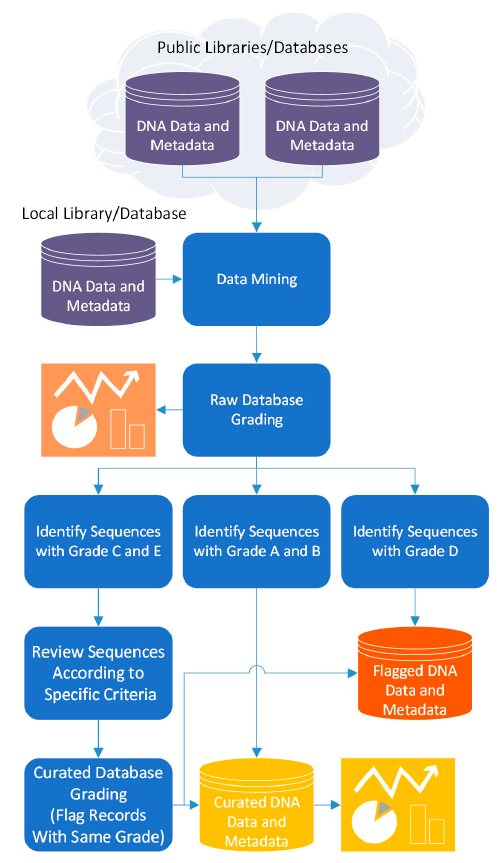
Figure 1. The pipeline flow of the 4SpecID computational tool.